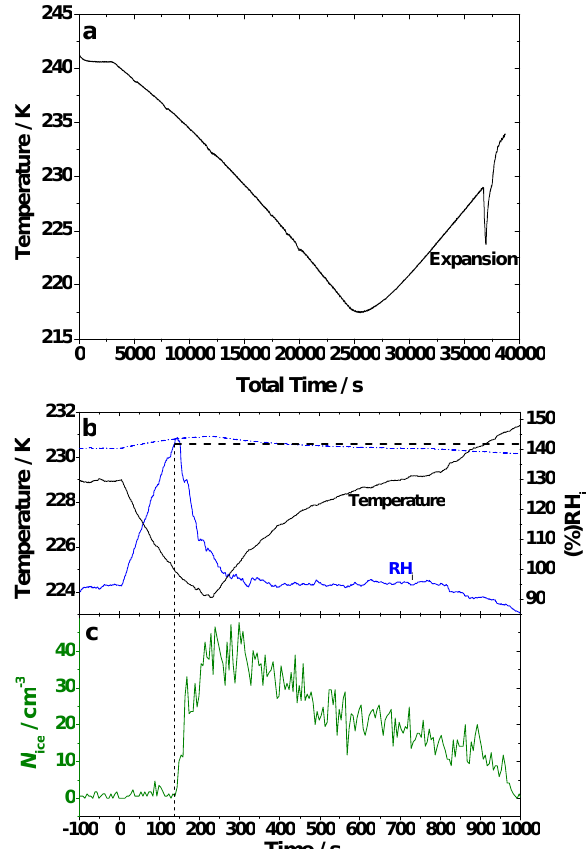
Fig. 4. Panel (a) shows the experimental temperature/time series for raffinose aerosol cooled to 217.5K then warmed up to 229K at which point an expansion was performed. Panel (b) shows the tem- perature and RH i (solid black and blue lines respectively) as well as the temperature dependent threshold humidity at which homo- geneous ice nucleation is expected to occur, based on AIDA exper- iments using liquid aqueous H 2 SO 4 aerosol (M¨ohler et al., 2003) (dot-dash blue line). Panel (c) shows the ice particle number con- centration, N ice . Homogeneous ice nucleation was observed at the predicted humidity, indicating that the aerosol had liquefied on ex- posure to increasing humidity, which would not have occurred had it